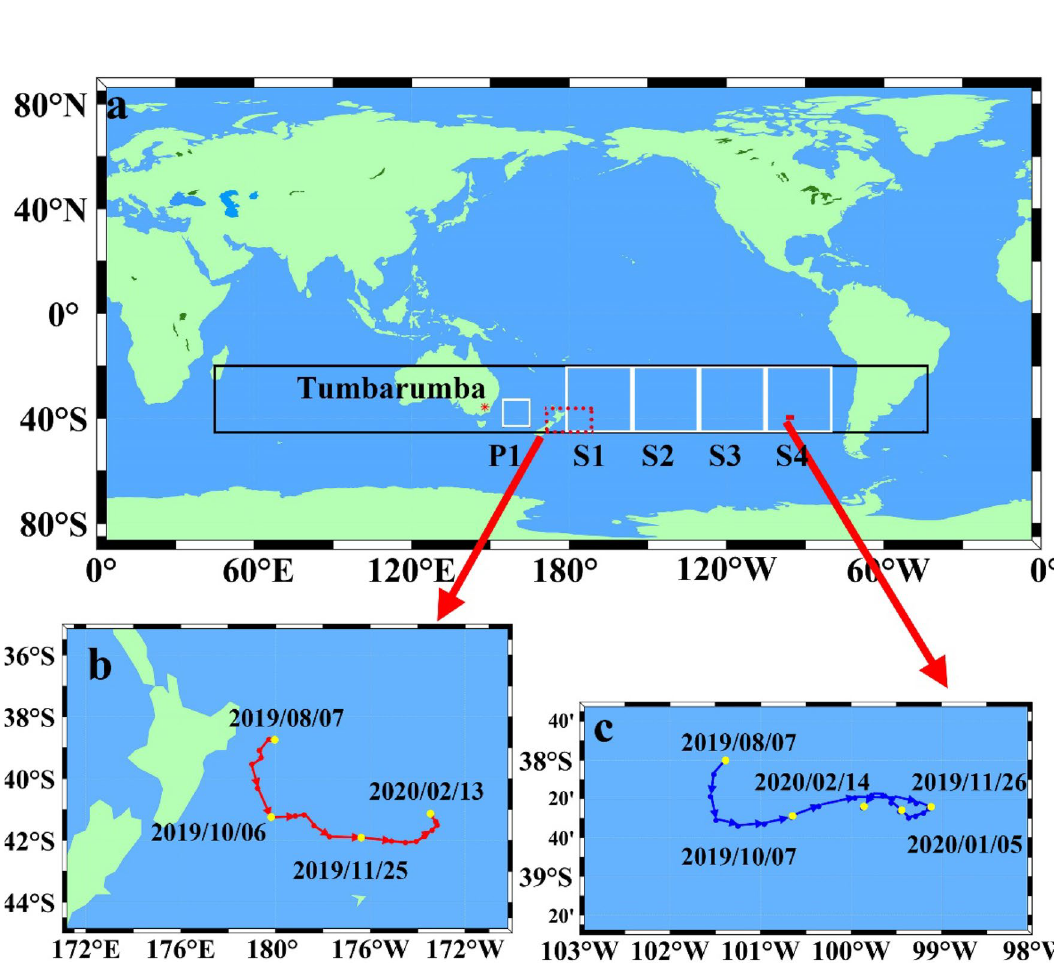
Figure 1. ( a ) Map of areas of interest (generated using MATLAB 9.9.0.1570001 R2020b Update 4, https:// www. mathw orks. com/ produ cts/ matlab. html). The black rectangle (20°S–45°S, 45°E–45°W) indicates the Hovmoller latitude-averaged plot in Fig. 2a. The red star represents the location of the AERONET site (Tumbarumba, Australia). The white boxes represent P1 (33°S–43°S, 155°E–165°E) and P2 (20°S–45°S, 180°–80°W), which contains 4 subparts of the same size (i.e., S1–S4). ( b ) Position and trajectory of No. 5905108 BGC-Argo float. ( c ) Position and trajectory of No. 5904843 BGC-Argo